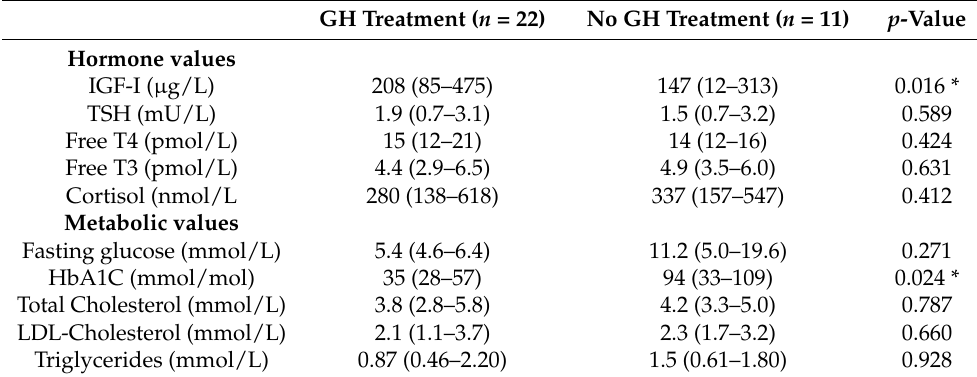
Table 1. Laboratory analyte and measurement characteristics of 33 adults with Prader-Willi syndrome. Results are shown as medians and ranges.